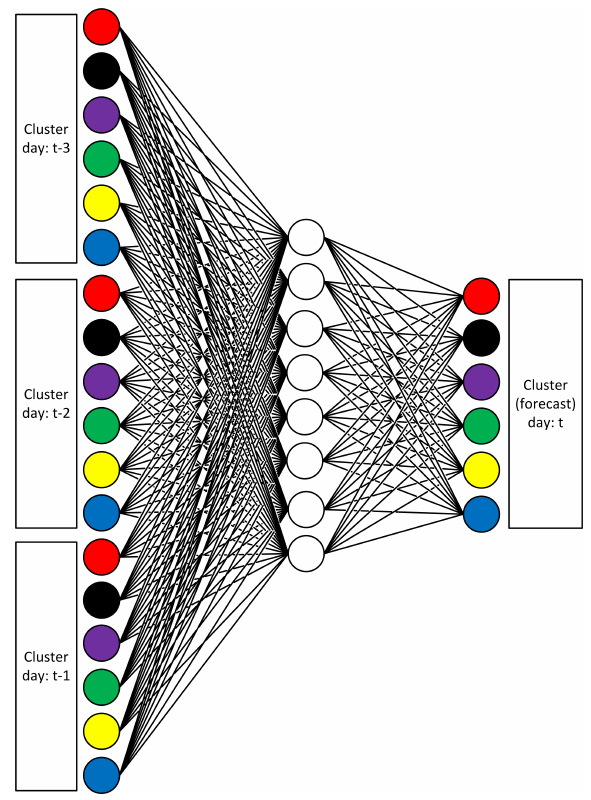
Figure 3. Structure of the